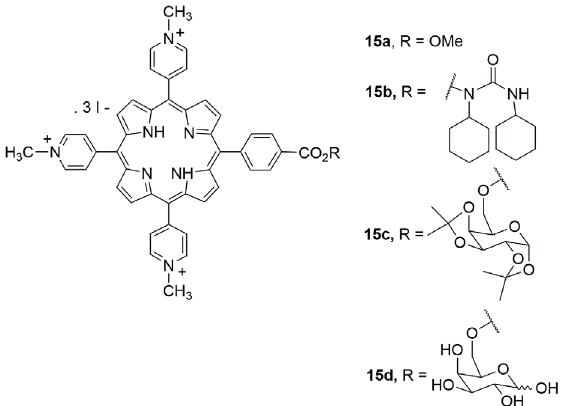
Figure 17 - Structures of tricationic porphyrin conjugates 15a- d